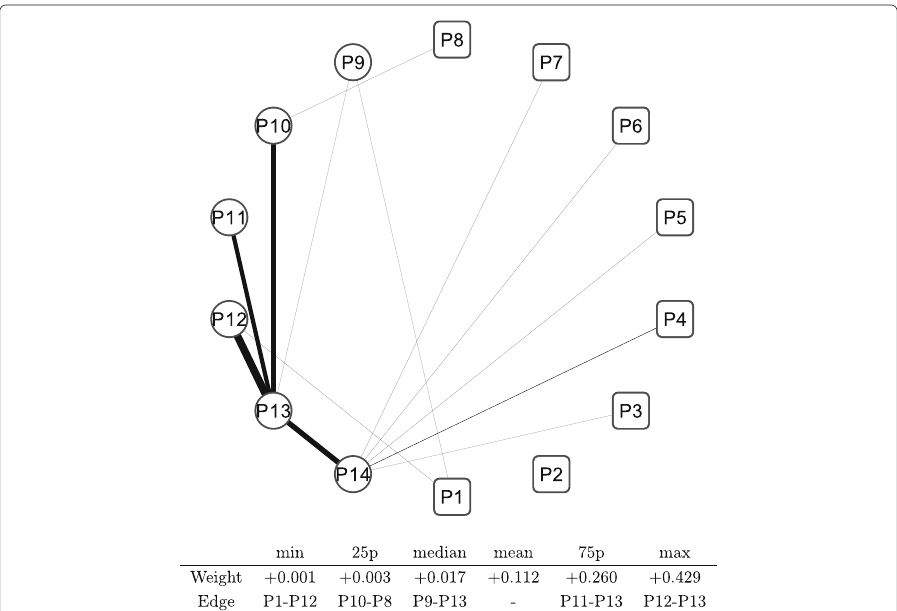
Fig. 17 Changes in network between sub-periods: T1–T3. Note: The network shows the difference between the sub-period T1 and T3. The edge weight (the edge width) is calculated by subtracting elements of the adjacency matrix of T3 from those of T1 described as T1 − T3. Only the edges that have positive weights (T1 > T3) are shown. The bottom table shows the quantiles of edge weights distribution with corresponding